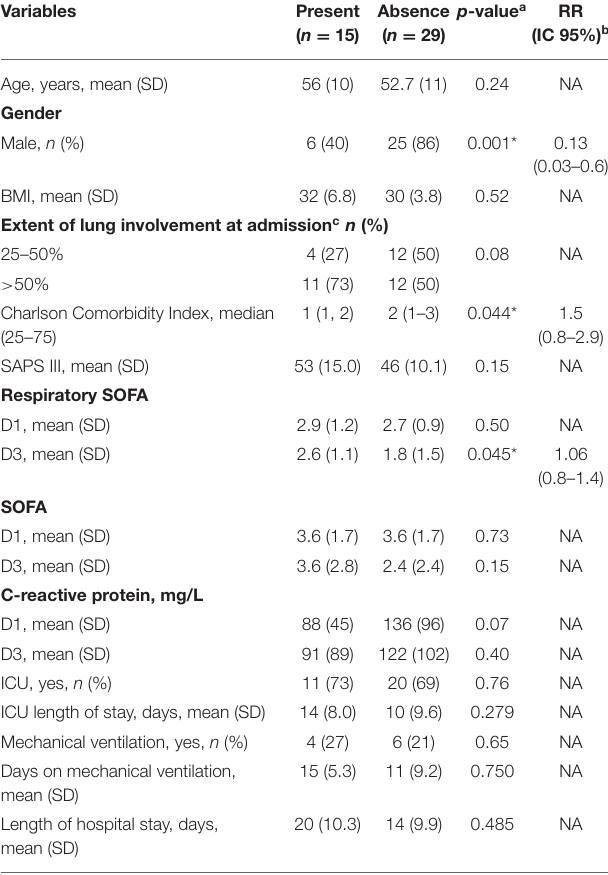
TABLE 2 | Variables associated with the persistence of lesions on lung CT scan 6-months after hospital discharge. Variables